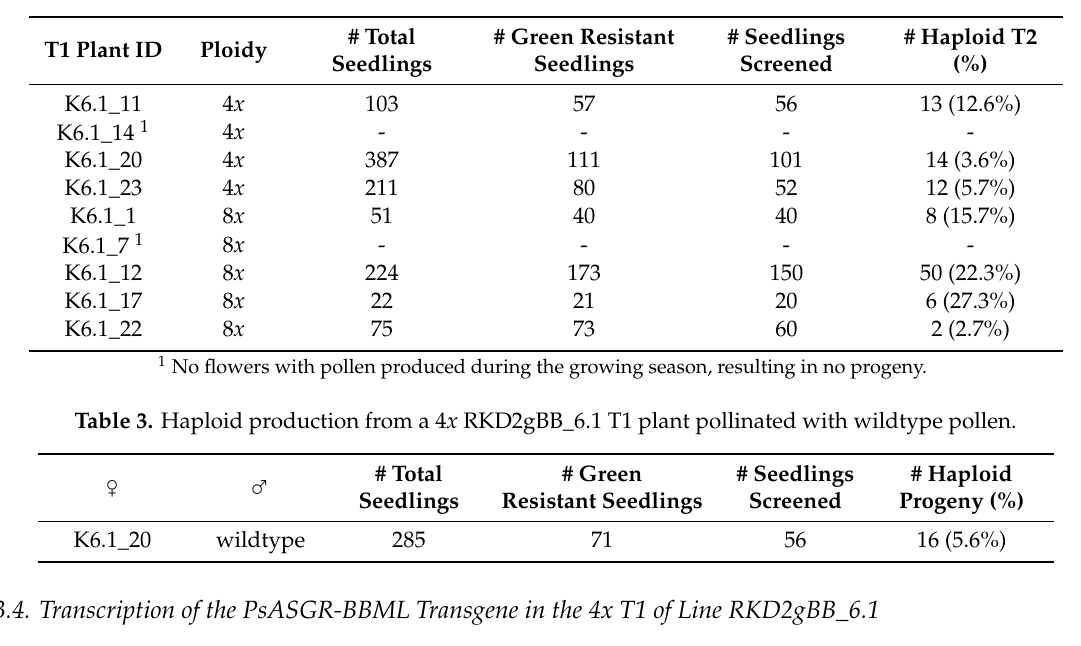
Table 2. E ffi ciency of haploid production in the RKD2gBB_6.1 T1 progeny after self-pollination.